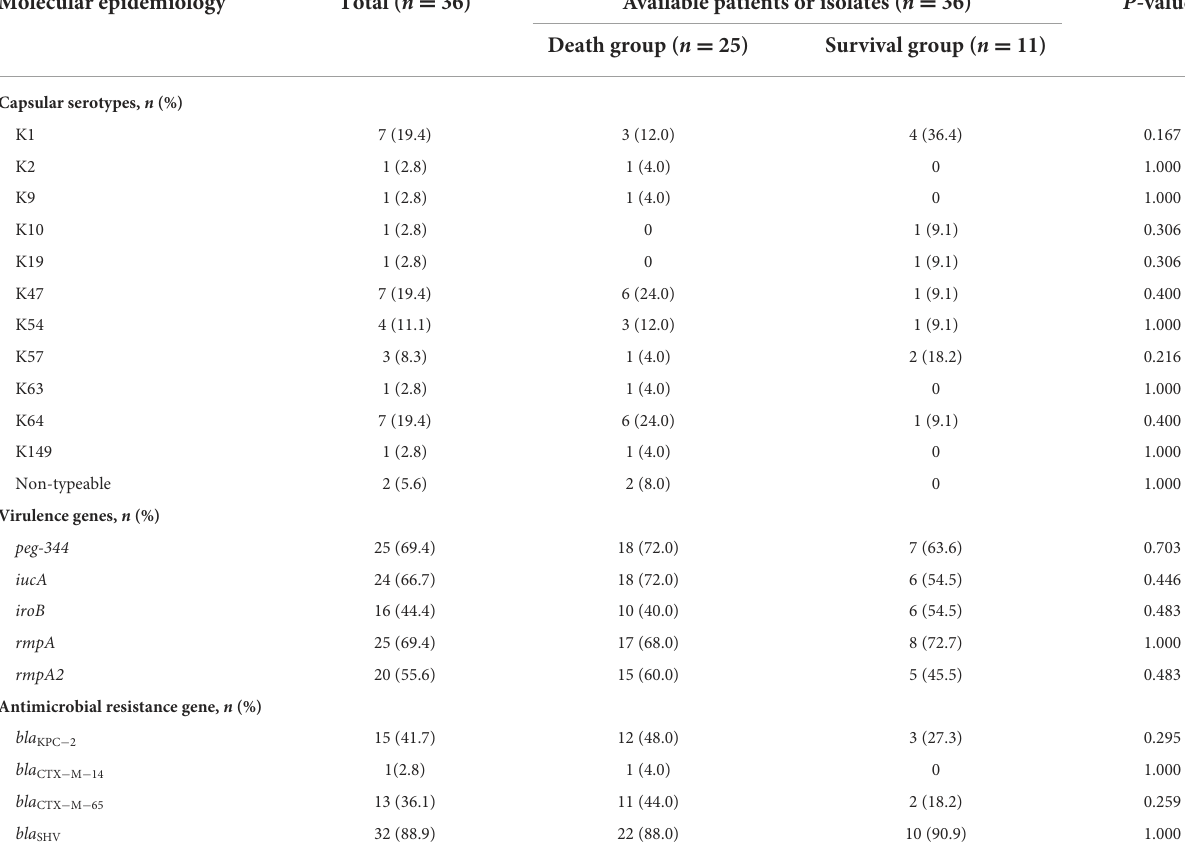
TABLE 3 Molecular epidemiology of 36 K. pneumoniae